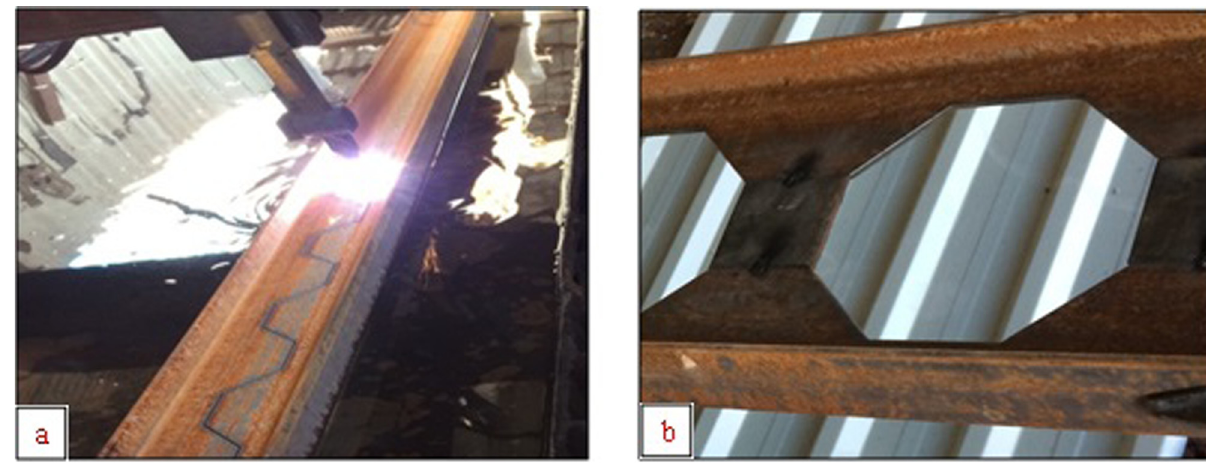
Figure 3: ( a ) Plasma CNC machine for cutting IPE140. ( b ) Placing the expansion plate and rejoining together.